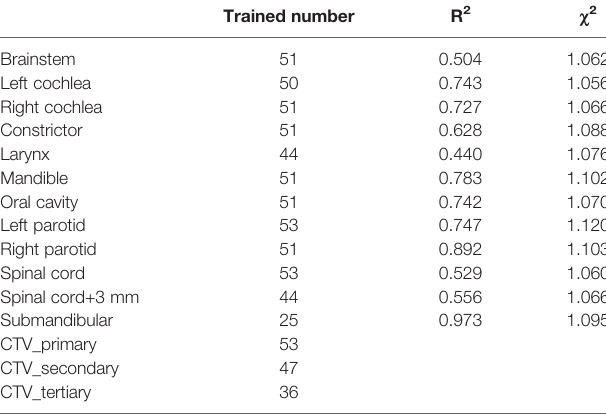
TABLE 3 | Model training results.